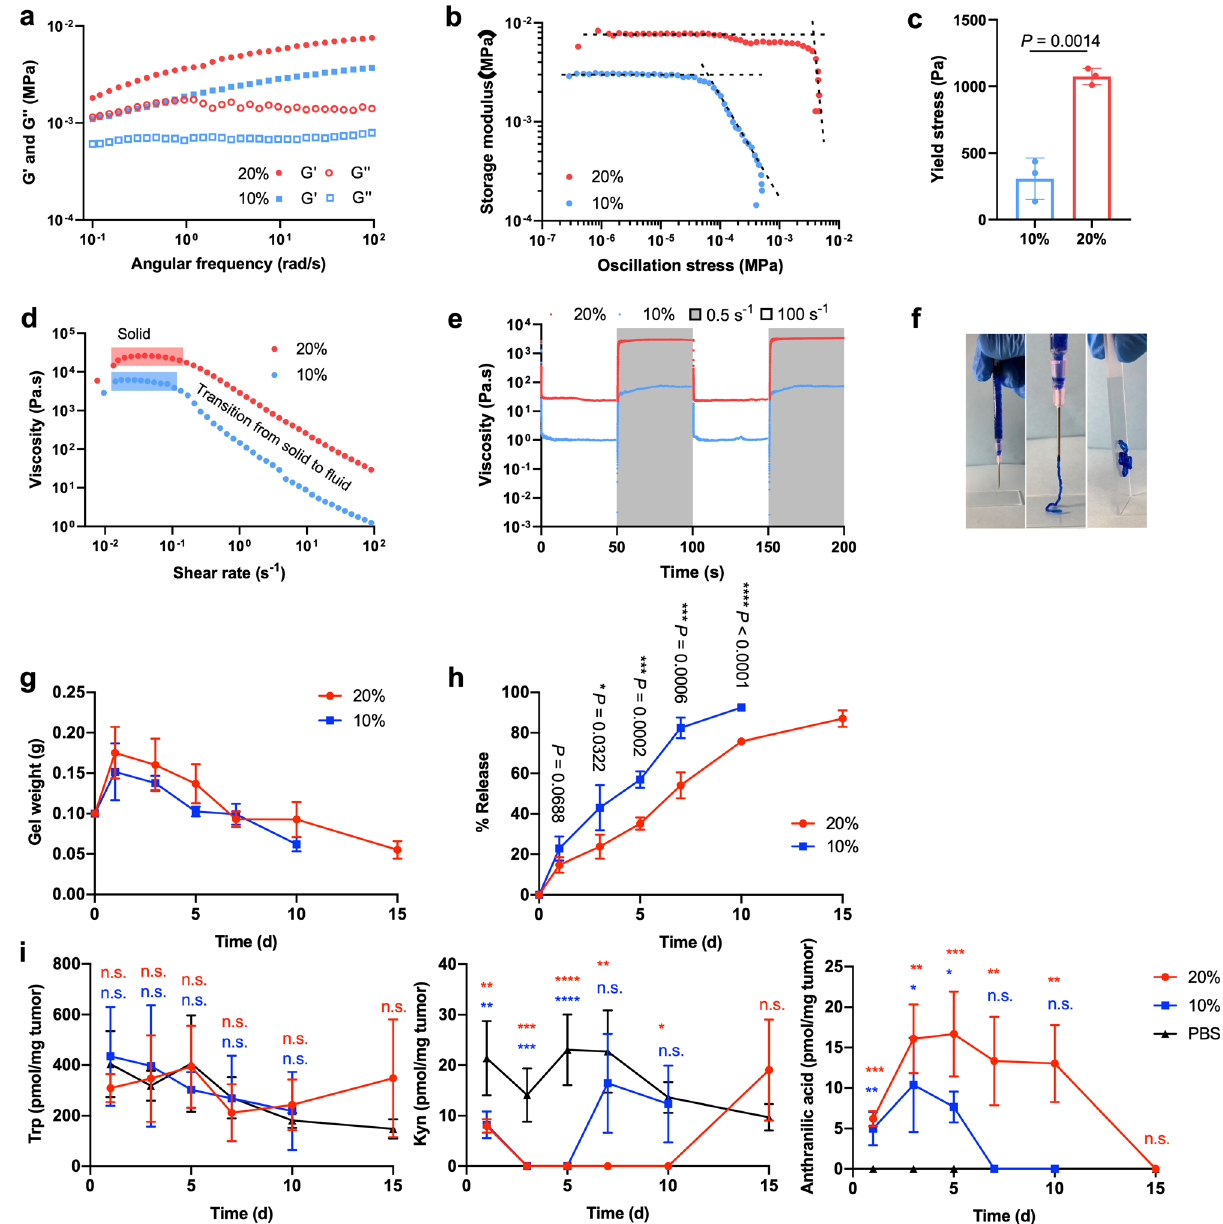
Fig. 2 The injectable hydrogel empowers sustained KYNase release and Kyn elimination in the tumor. a Frequency-dependent (strain = 0.1%, 37 °C) oscillatory shear rheology. b Stress ramp rheology of two hydrogel formulations. c Yield stress values from stress ramp measurements ( n = 3). d Steady shear rheology of 10% and 20% hydrogels. e Step-shear measurements of 10% and 20% hydrogels over two cycles with alternating high shear (100 s − 1 ) and low shear (0.05 s − 1 ) rates. f Images of 20% hydrogel injection through an 18-gauge needle before injection (left), during injection (middle) and after injection (right) (the hydrogel was mixed with a blue food dye for easier visualization). g Degradation kinetics of 10% and 20% hydrogels in 4T1 tumor- bearing mice. h KYNase release from 10% and 20% hydrogels in 4T1 tumor-bearing mice over time. i Levels of Trp, Kyn, and anthranilic acid in the tumors from 4T1 tumor-bearing mice treated with 10% and 20% hydrogels loaded with KYNase. Metabolite concentrations below the detection limit were assigned to 0. In g – i , n = 4 biologically independent samples for the hydrogel groups, and n = 3 for PBS group. Throughout, data are presented as mean ± s.d., and statistical signi fi cance was determined by two-tailed t -test with Welch ’ s correction ( c , h ), or one-way ANOVA with Turkey ’ s post hoc test ( i , day 1 to day 10) and two-tailed t -test with Welch ’ s correction ( i , day 15). * P < 0.05, ** P < 0.01, *** P < 0.001, **** P < 0.0001, n.s., not signi fi cant. Source data and exact P values are provided as a Source Data fi